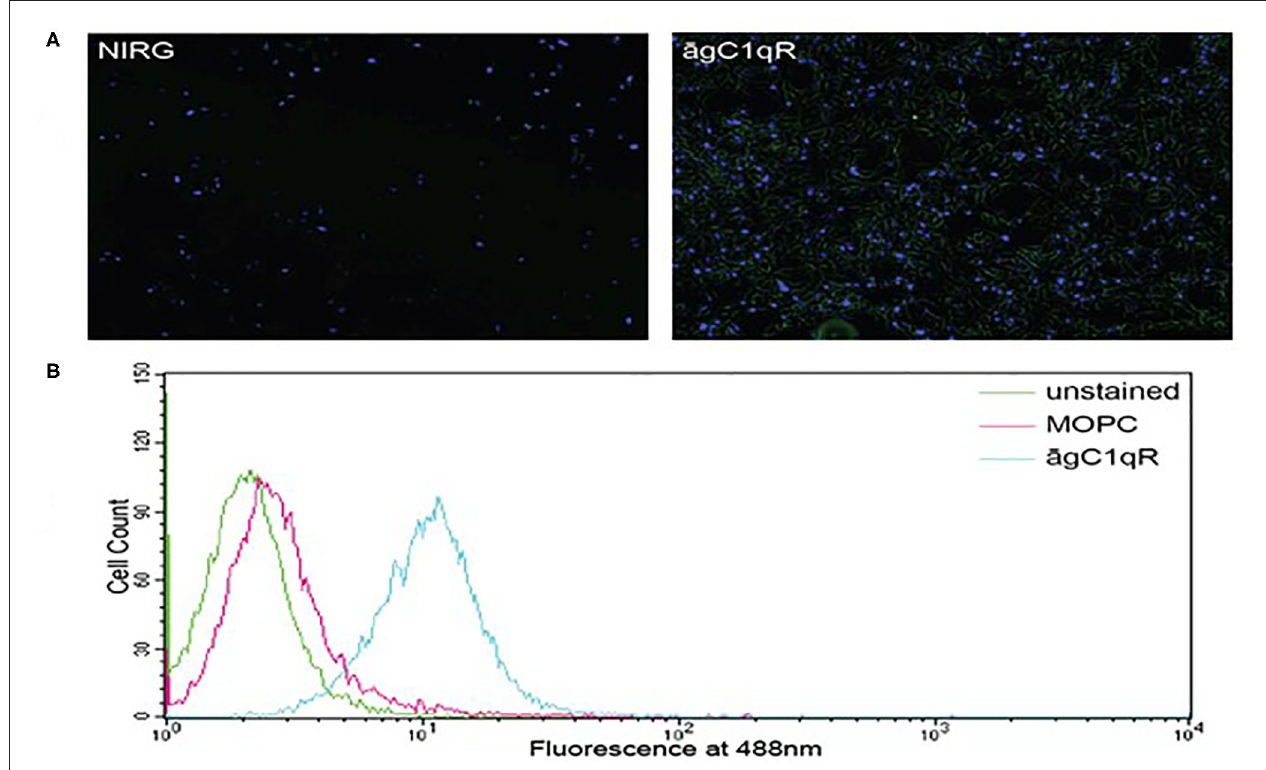
FIGURE 1 | Mesothelioma MSTO-211H cells expresses gC1qR. (A) Immunofluorescence photomicrographs of stained MSTO-211H cells in culture. Results of a typical experiment. Non-permeabilized cell monolayers were stained with non-immune rabbit IgG (NIRG) or 60.11 anti gC1qR antibody (¯agC1qR) and appropriate secondary antibodies conjugated to AlexaFluor 488 (green), as well as DAPI nuclear stain (blue). Cells were imaged with a fluorescence microscope at 10 × magnification. The presence of gC1qR is shown by green staining in the right image. (B) Flow cytometric analysis of MSTO-211H cell surface gC1qR expression. Non-permeabilized MSTO-211H cells in suspension were stained with non-immune mouse IgG (MOPC) or anti gC1qR antibody (¯agC1qR) and appropriate secondary antibodies conjugated to AlexaFluor 488. Stained and unstained cells were analyzed. Expression of cell surface gC1qR in a typical experiment is shown by an increase in fluorescence of cells treated with anti gC1qR antibody (blue